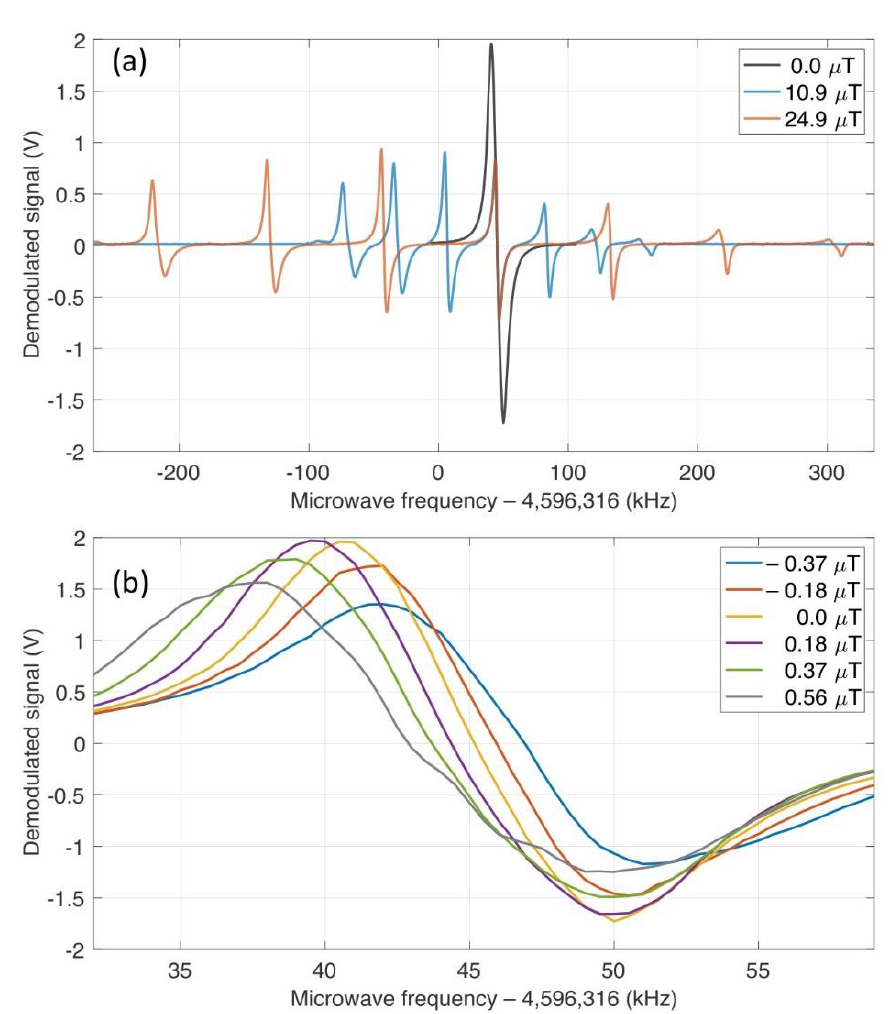
Figure 4. ( a ) Coherent population trapping (CPT) spectra as a function of microwave frequency for finite-field measurement (blue for 10.9 μT and red for 24.9 μT) and zero-field measurement (black) showing all possible resonances between magnetic sublevels given the magnetic field. ( b ) CPT spectra for a series of small magnetic fields varying near 0 μT.